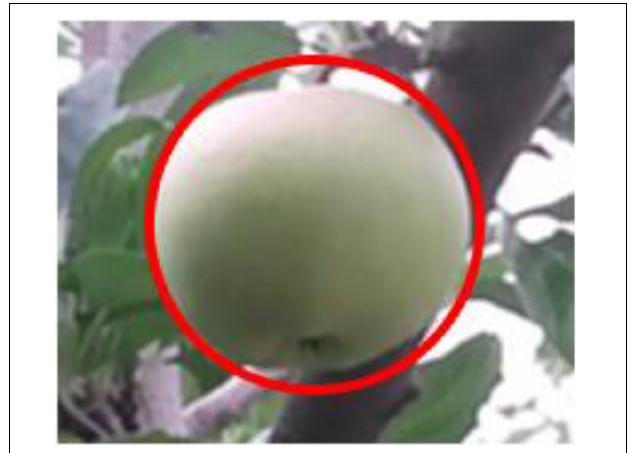
FIGURE 14 | Fitting effect of target fruit.